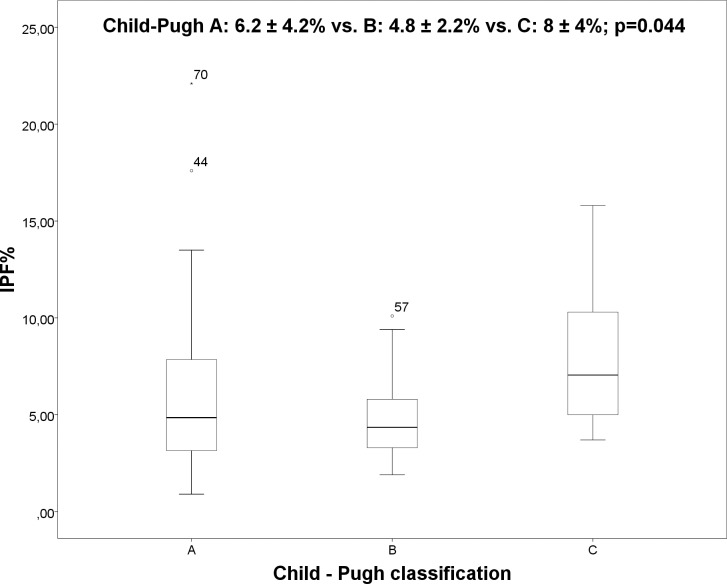
Boxplot: IPF% and Child-Pugh classification.